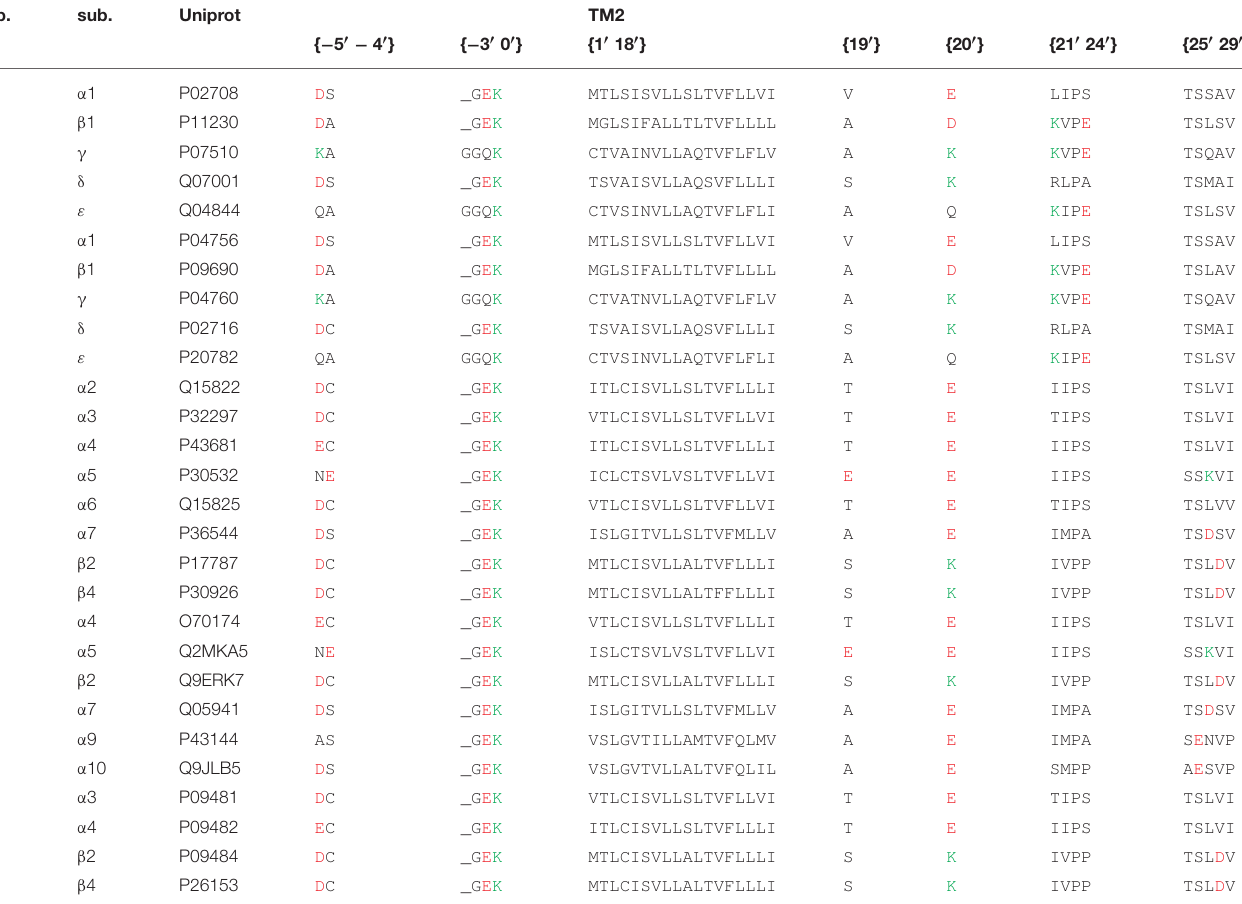
TABLE 1 | Sequences of amino acids near and in TM2 transmembrane regions of 28 nAChR subunits. sp.